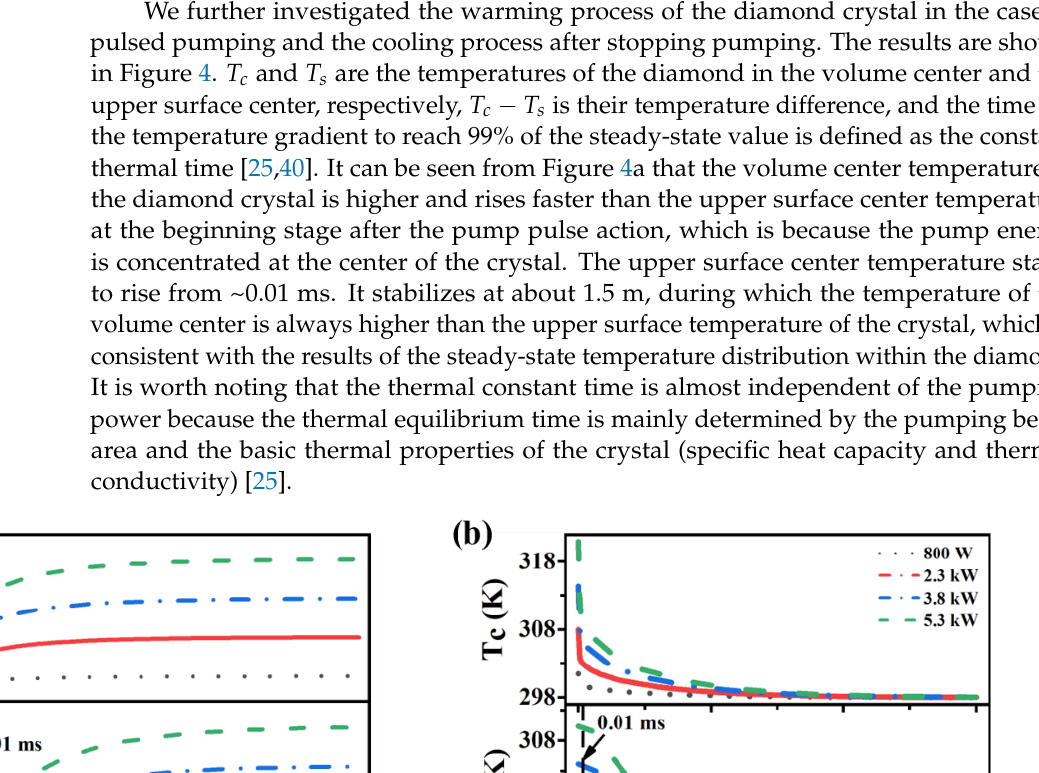
Figure 3. Temperature distribution of ( a ) x-axis intercept in crystal center plane, ( b ) y- axis intercept in crystal center plane, and ( c ) crystal axis at different pumping power levels.